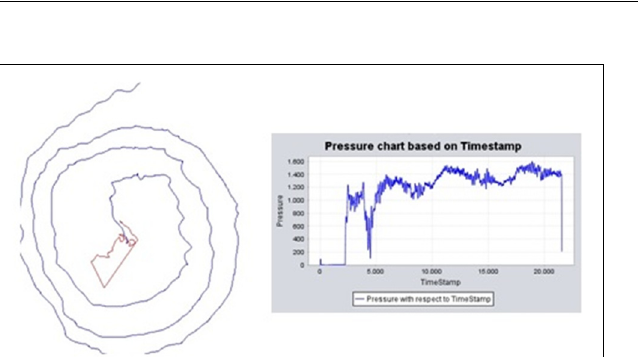
FIGURE 4 | Diagram of the handwriting acquisitions system and example of recorded signals.